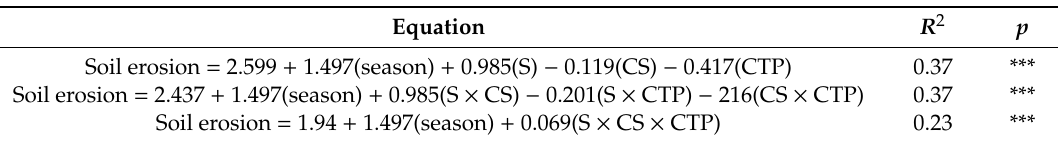
Table 2. The linear prediction equation of soil erosion (t ha-1) using the land slope (S), cropping systems (CS), conservation tillage practices (CTP), and interactions (S × CS, S × CTP, CS × CTP, and S × CS × CTP) during the two growing